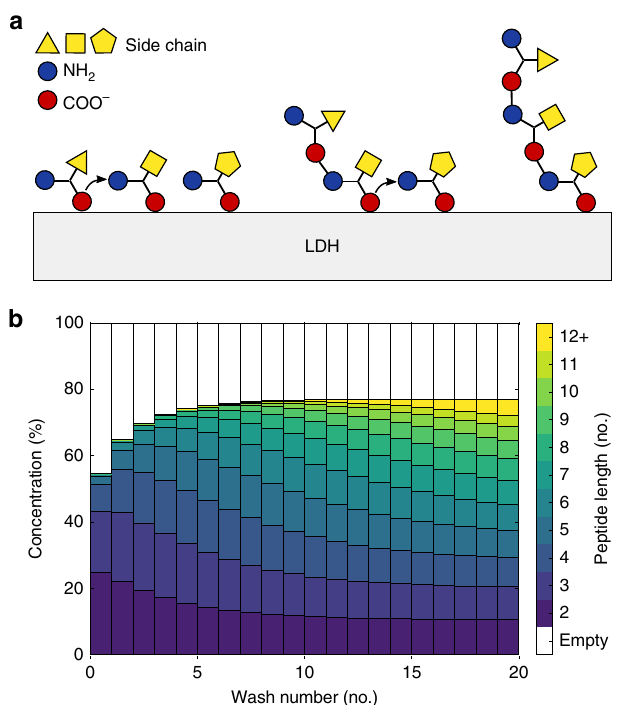
Amino acid adsorption . The percentages of adsorbed amino acids were calculated for all dehydration studies and reported as a function of the hydration of the systems (Fig. 2a). For peptide systems (di-peptide, hexapeptide, and mixtures of peptides) the adsorption percentages were also calculated (Fig. 2b). The amino acid/peptide was considered to be adsorbed when a C-terminal oxygen (OT1 and OT2) forms an H-bond with the LDH surface. We adopted a distance cutoff of 2.5 Å, corresponding to the distance of the fi rst hydration layer of LDH. Aspartate can also adsorb via its side-chain (OD1 and OD2), which is reported separately. In the case of di- and hexa- peptides there are twice or six times, respectively, more side- chains than in the backbone and so their adsorbed percentages are scaled accordingly. Radial distribution function . For all the dehydration studies, we computed the radial distribution function (RDF) and the C-terminal atoms of the amino acids using LDH aluminum as reference (Supplementary Fig. 3). The RDF allows us to describe the templating effect of LDH on the arrangement of the amino acids. For comparison, the RDF of aluminum atoms against themselves was also calculated. Vectorial analysis . We calculated the alignment of every amino acid adsorbed with respect to the xy -plane of the LDH surface. A vector was assigned between C and N in the backbone, and its elevation as described in spherical coordinates ( Θ angle) collected. Histograms of elevations were generated with 1° bin size. Angles of 0° identify vectors perpendicular to the plane, and 90° those parallel to the plane (Supplementary Fig. 4). Reactive pair count . For dehydration studies, the likelihood of amino acids co-aligning to form a peptide was calculated (Fig. 3). A reactive pair may be de fi ned as two adsorbed amino acids with their respective C- and N- termini at less than 4 Å distance from one another. In the case of aspartate, alignments that can lead to cyclic reaction were excluded, and the total count of reactive pairs that could lead to either alpha- or beta- peptides is presented.